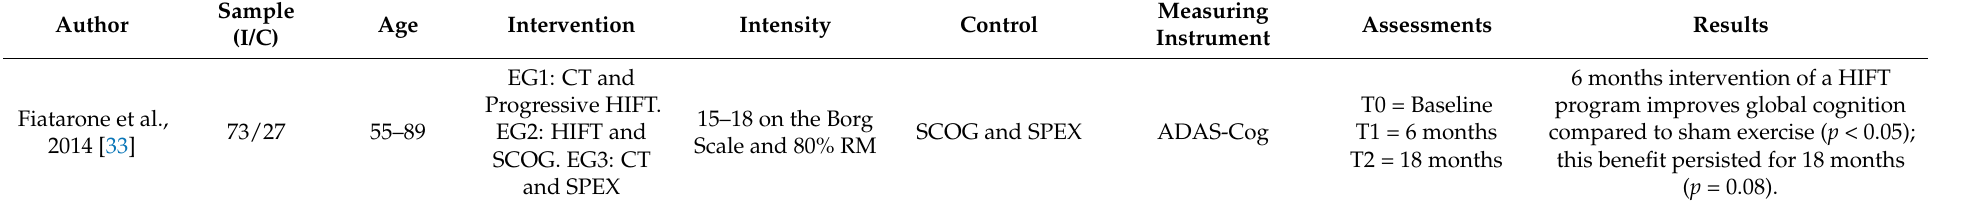
Table 3. Characteristics of the included